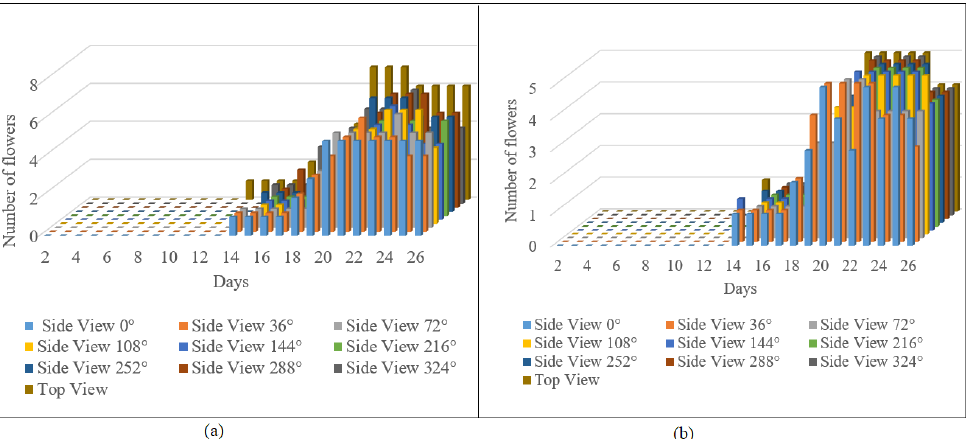
Figure 16. The flower status graphs for two sample sunflower plants: ( a ) Plant-ID D5; ( b ) Plant-ID